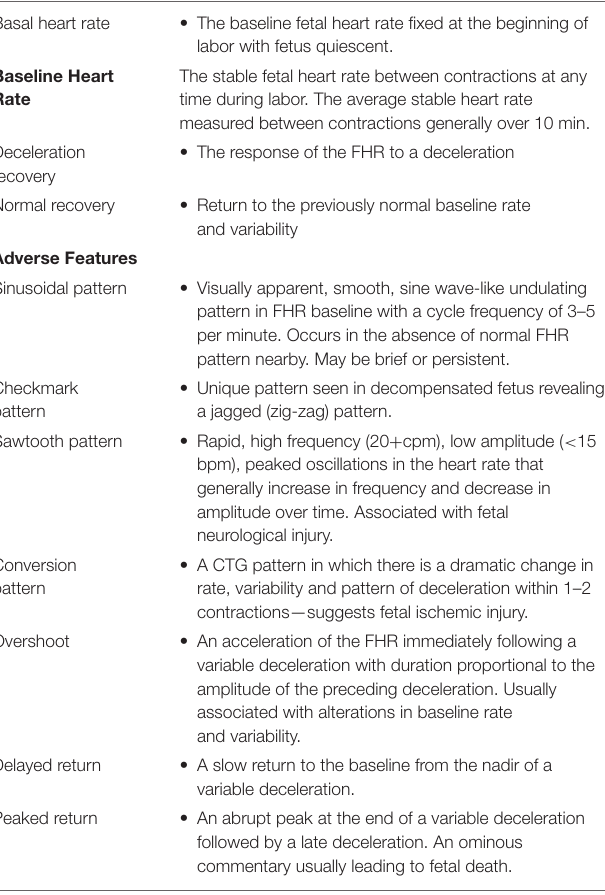
TABLE 1 | Electronic fetal monitoring definitions. Basal heart